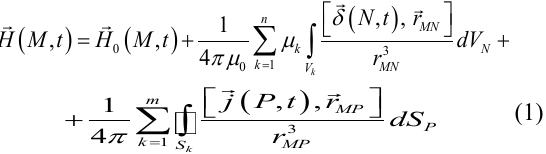
Fig. 2. Magnetooptical images of a weld in a stainless steel sample with orthogonal excitation of eddy currents with frequencies: a - 8, b - 15, c - 30, d – 45 kHz.